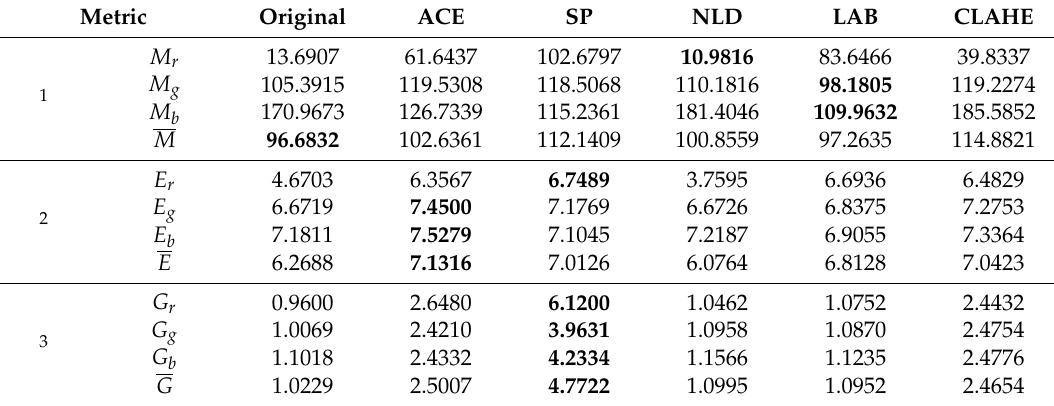
Table 2. Results of benchmarking performed on “MazotosN4” image with the objective metrics. Metric Original